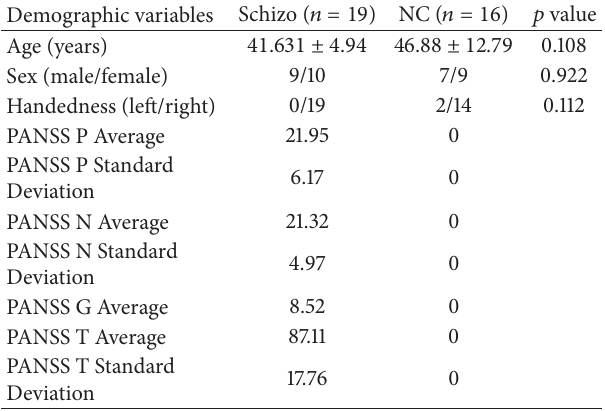
Table 1: Comparison of demographic characteristics between con- trols and